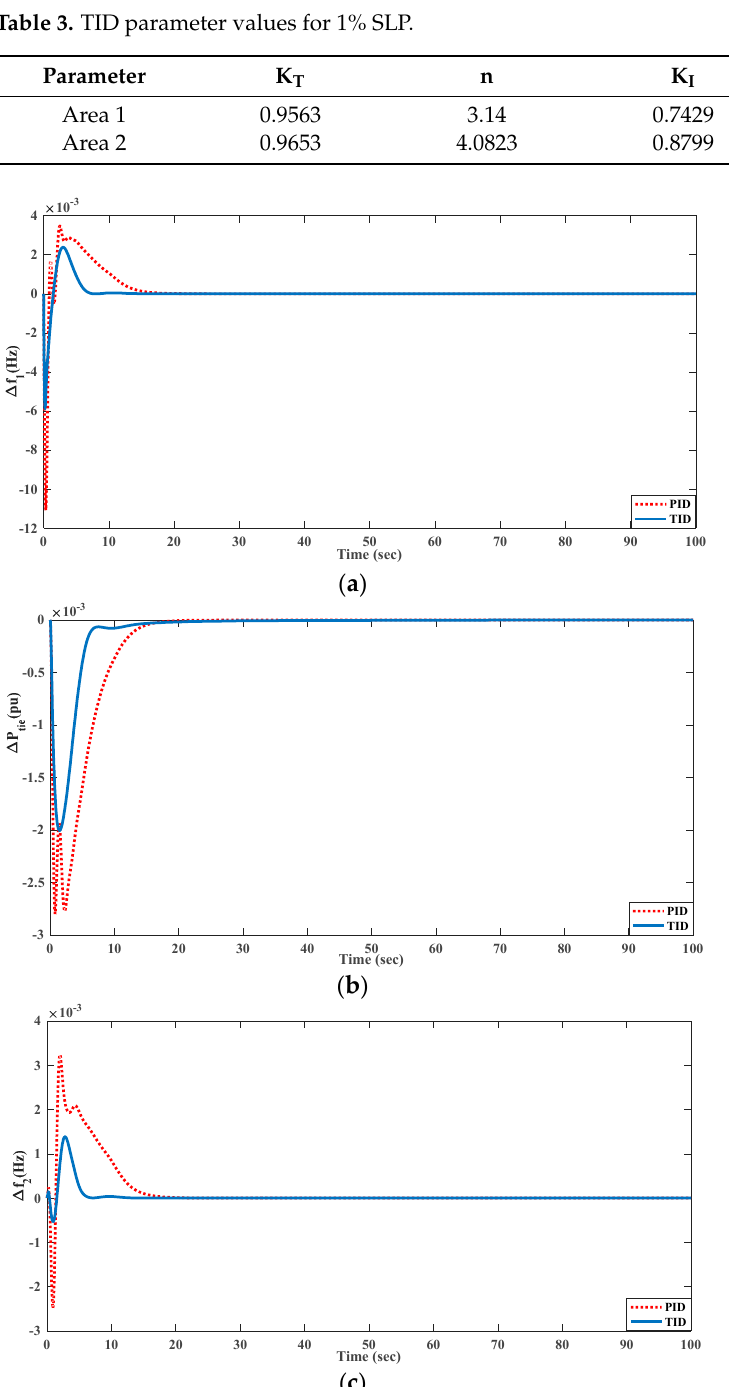
Figure 10. Simulation results: comparison of the performance of the PID and TID controllers with 1% SLP in area 1. ( a ) Δ f 1 ; ( b ) Δ P tie ; ( c ) Δ f 2.